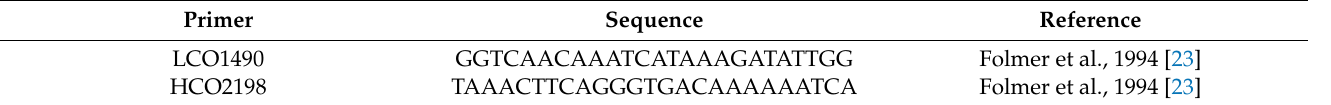
Table 3. PCR primers used to sequence mt COI genes of Eoneureclipsis species in this study. Primer Sequence Reference